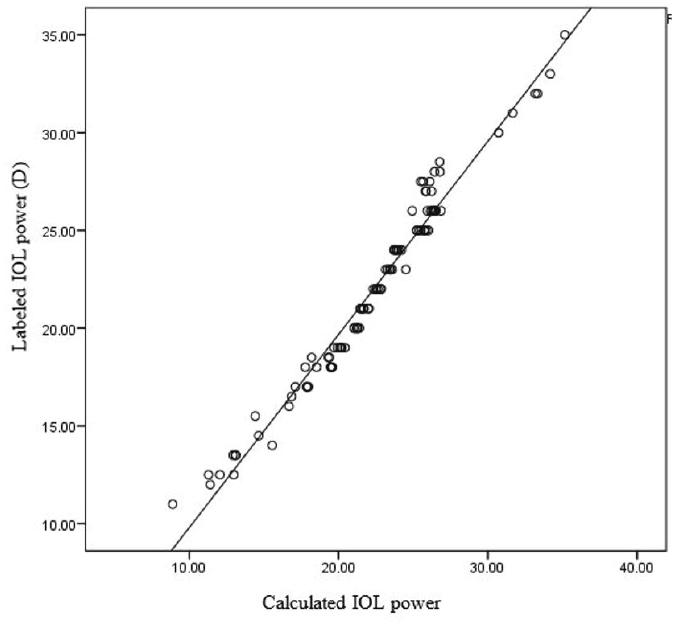
Figure 3. Plot of labelled IOL power against IOL power calculated by the measured regression equation showing significant correlation.